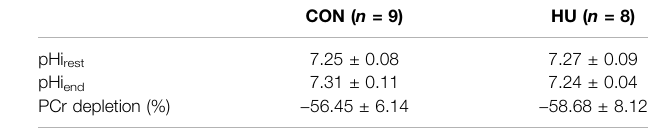
TABLE 1 | Muscles and body weights in HU and CON mice.